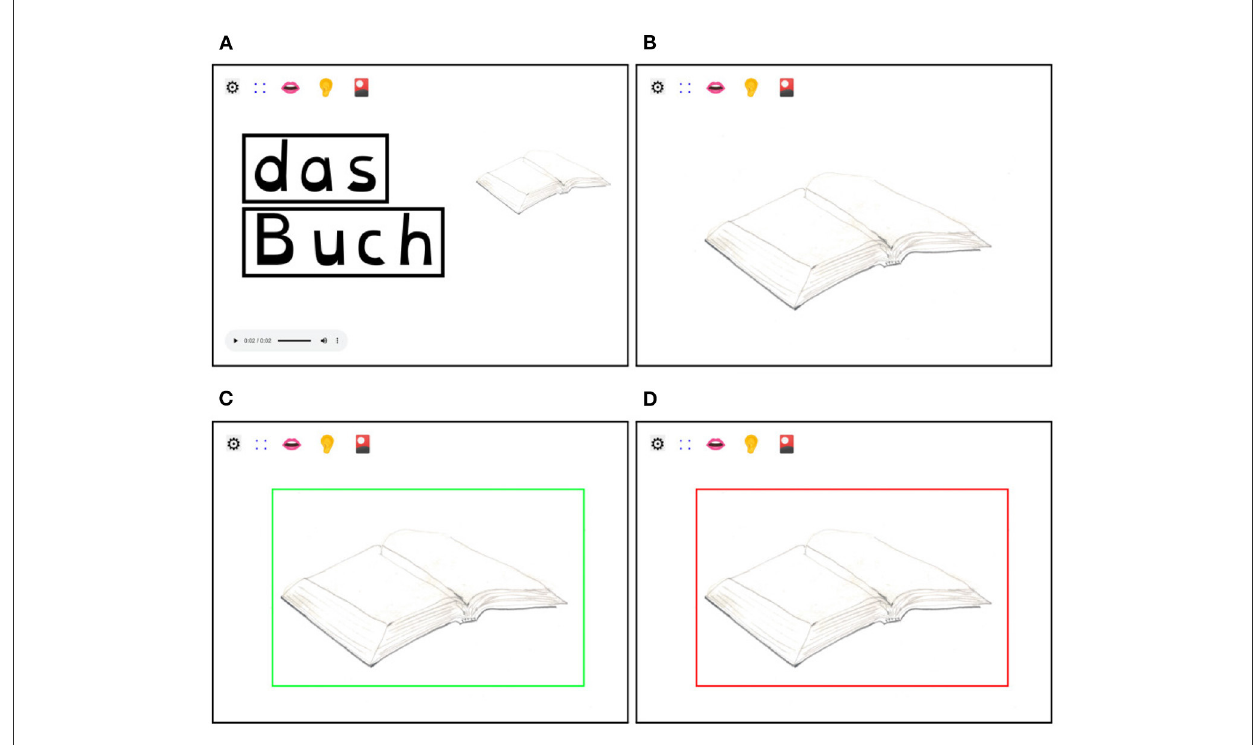
FIGURE2 Web-based Interface of HMPL-C1-E1 (A) Learning phase. (B) Test + Feedback phase. (C) Correctly recognized. (D) Not